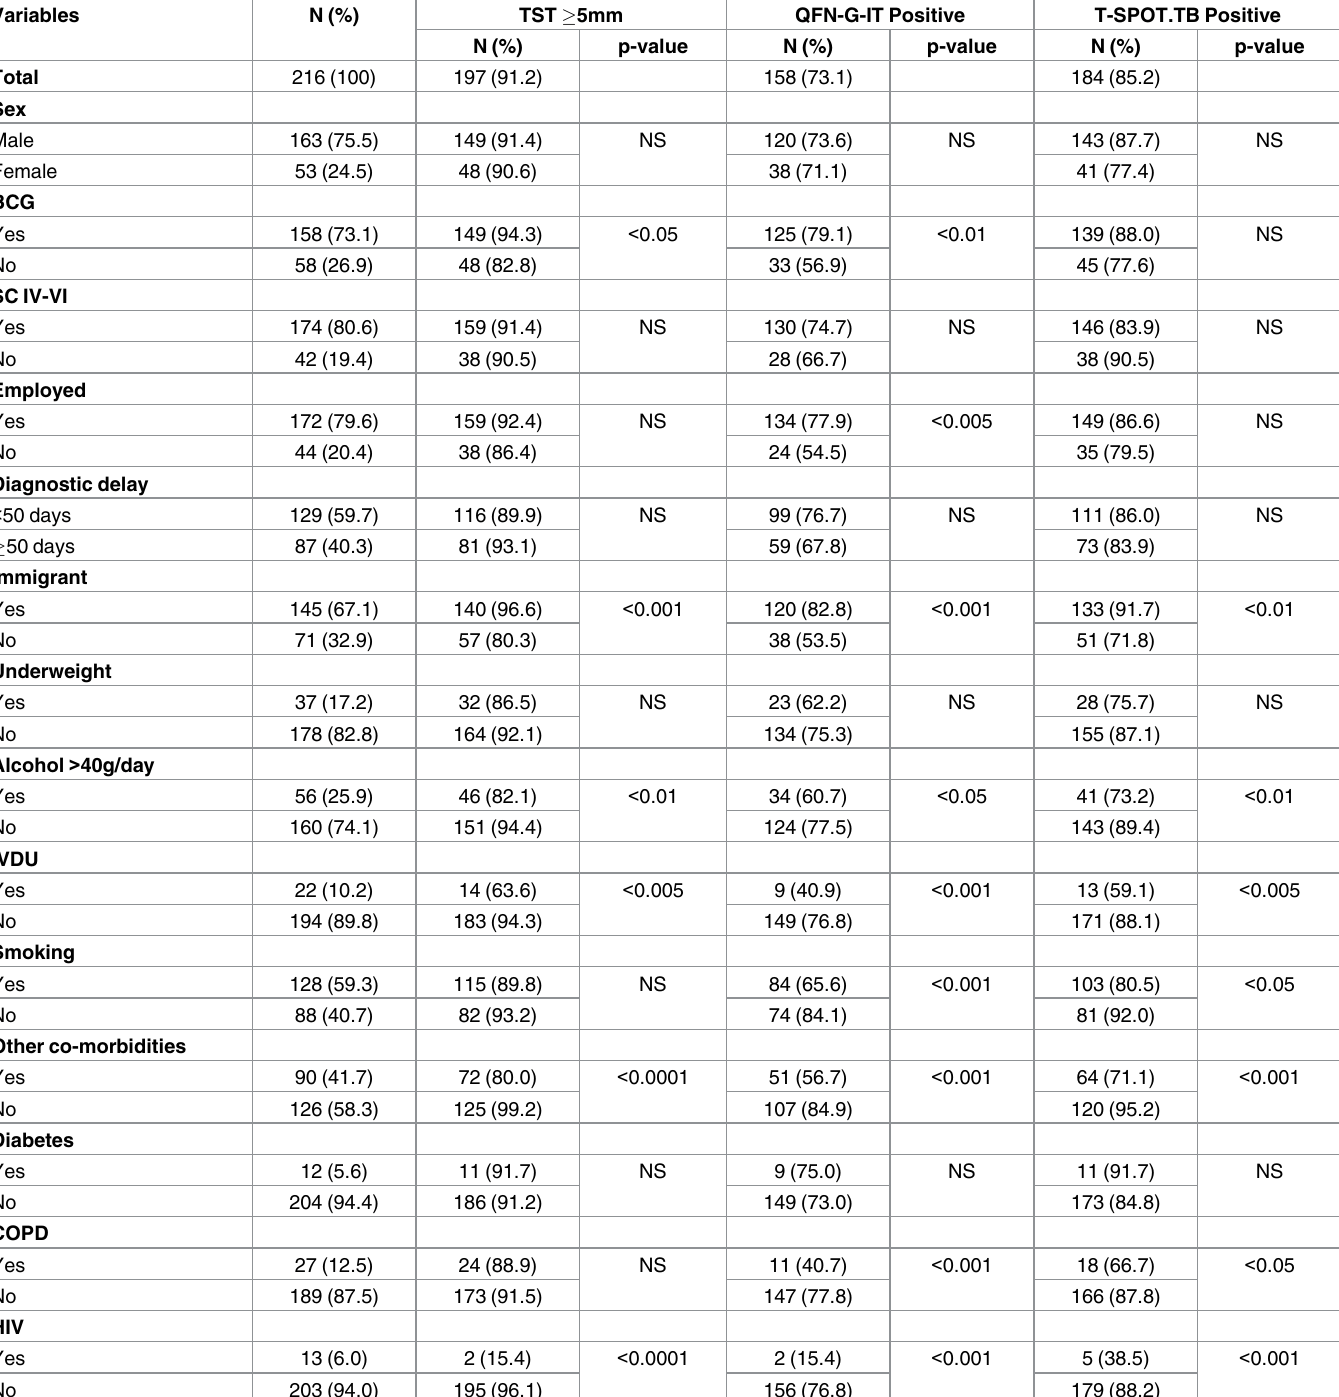
Table 1. Main demographic characteristics and risk factors according to TST and IGRAs results in TB diseased patients.